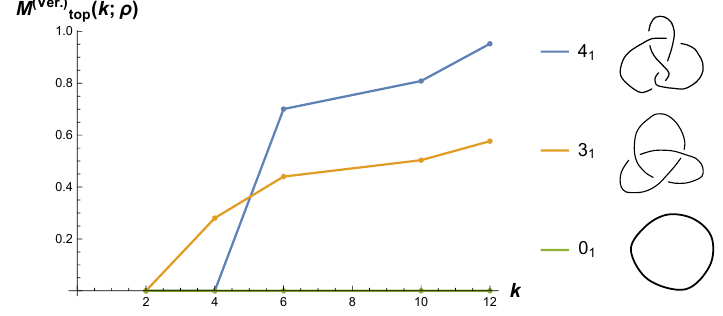
Figure 2 . The dependence of M top over the allowed values of k for a few distinguished knots: the unknot ( 0 ), the trefoil ( 3 ), and the figure-eight knot ( 4 ). The contours are interpolating lines 1 1 1 only meant to guide the eye, M is only defined for k = 2, 4, 6, 10, and 12 in this top